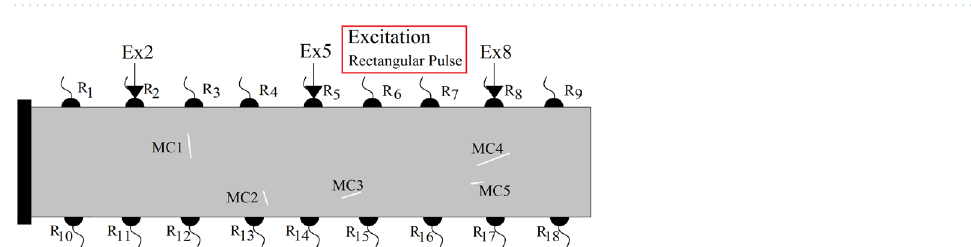
Figure 9. The recorded time histories at the receiver sensors under consideration of different crack conditions. Besides the direct wavefronts, the reflected and diffracted wave fronts are clearly visible by the different arrival times.